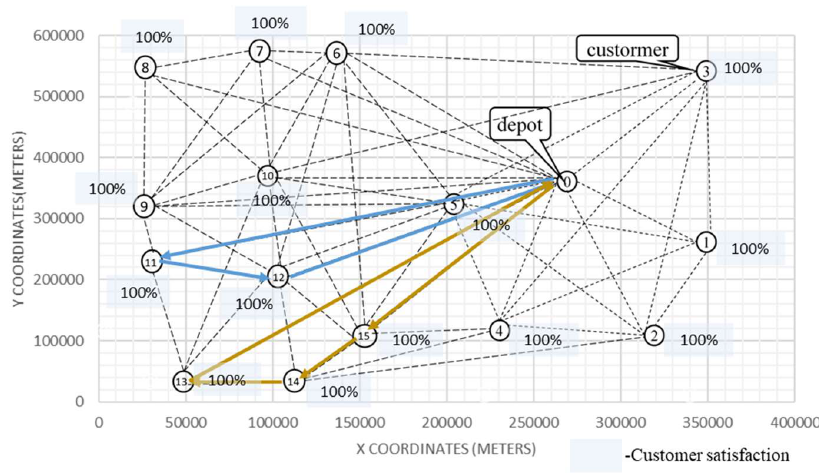
Figure 20. Obtained flight-mission plan for the last FTW.